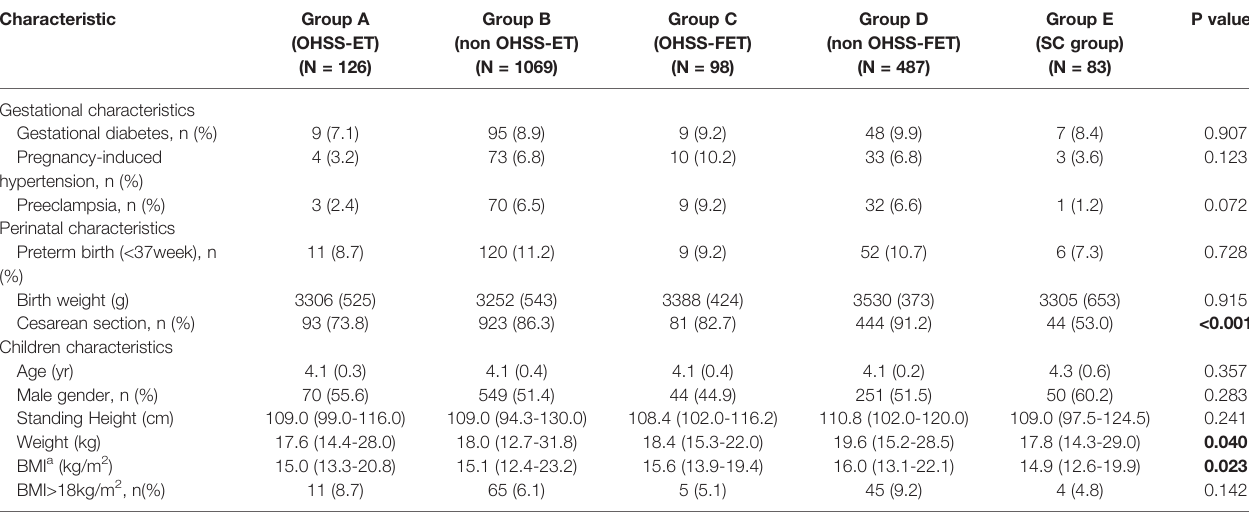
TABLE 2 | Demographic data on children and perinatal characteristics. Characteristic